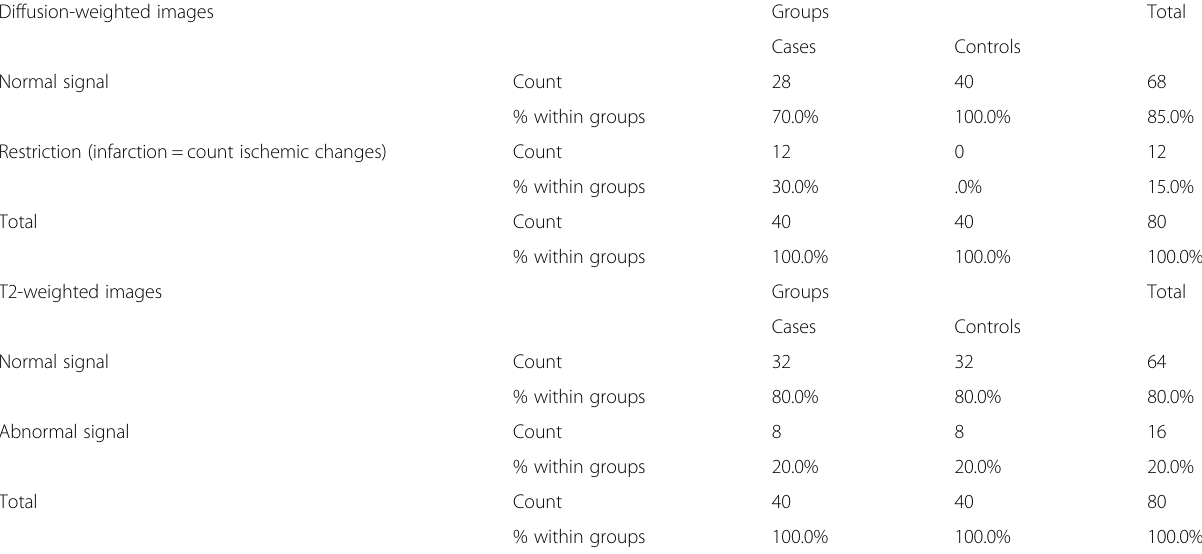
Table 3 Demonstrated MR findings at T2- and diffusion-weighted imaging in the included hypertensive pregnant patients Diffusion-weighted images